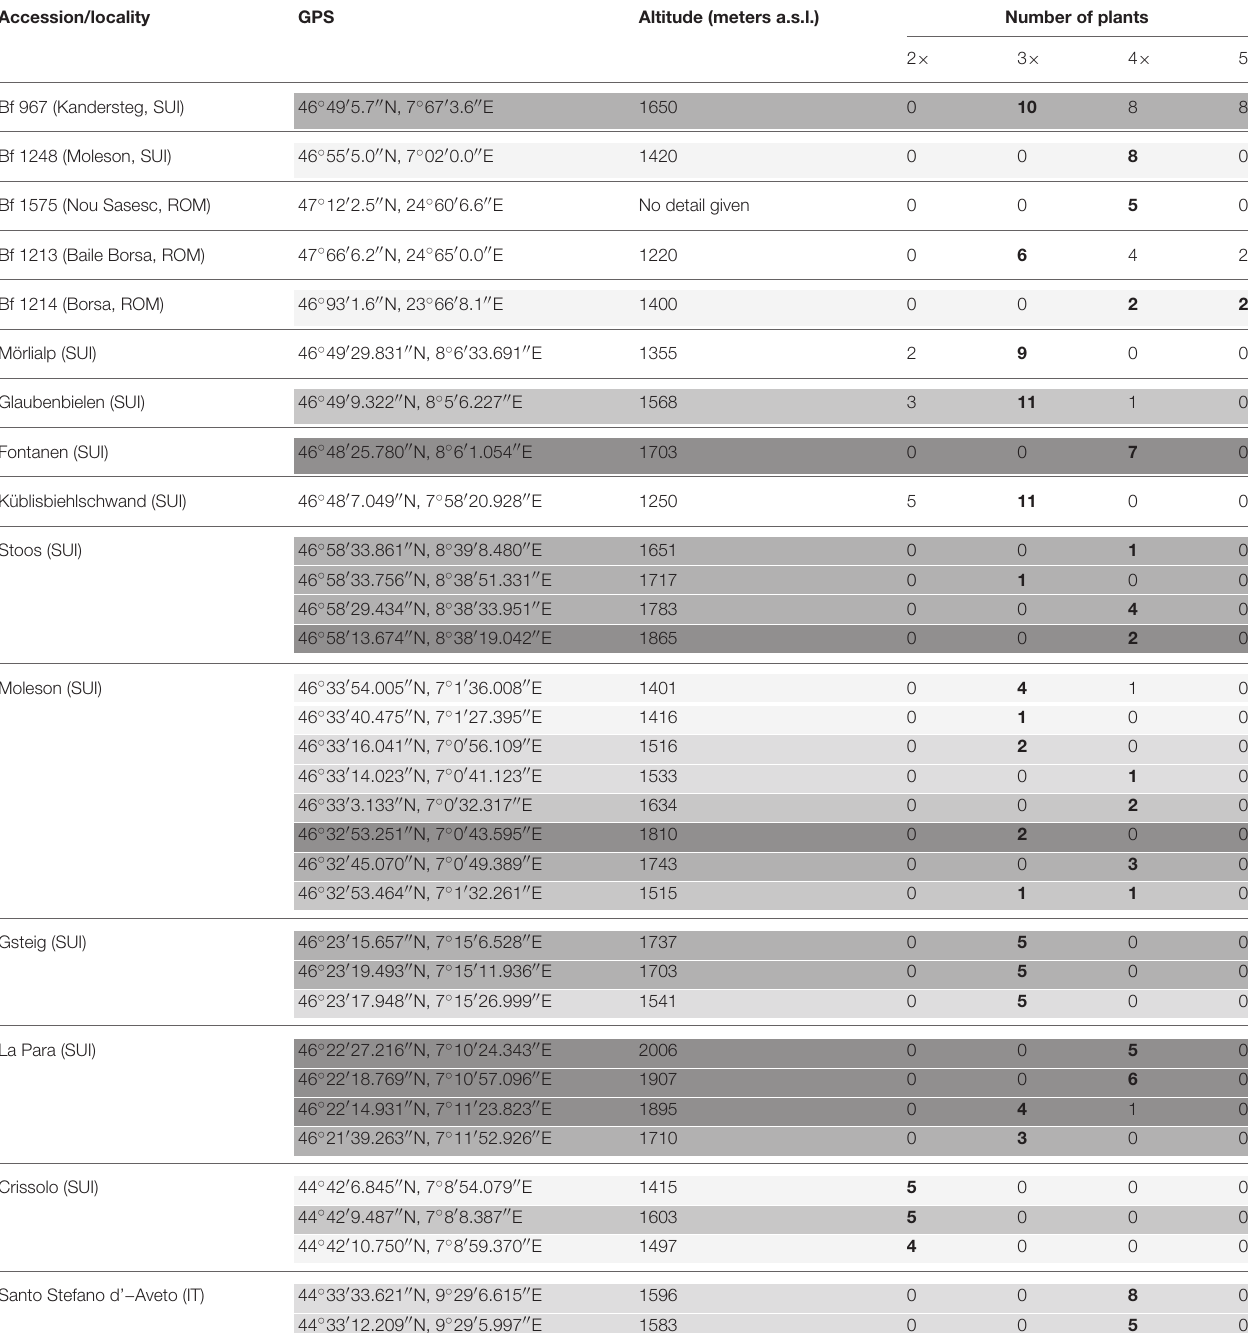
The altitude of the localities is highlighted by the gray scale. The most frequent cytotype is